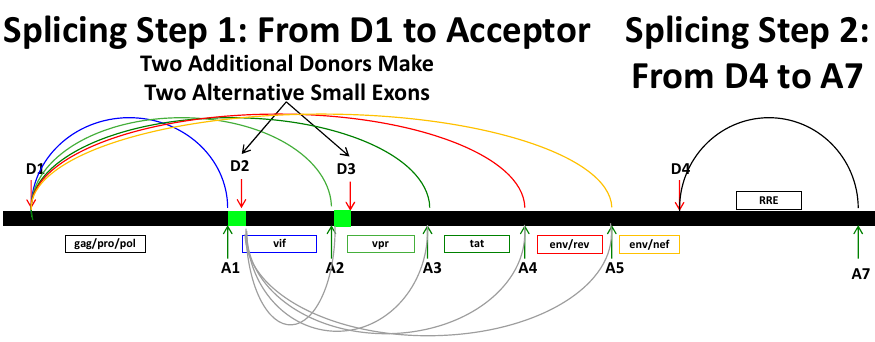
Figure 1. Splicing in HIV-1. Most HIV-1 transcripts remain unspliced. When splicing occurs, it always splices from D1 to one of the downstream acceptors, removing a section under a colored arc. Once having spliced from D1, the RNA may splice again to remove the sequence between D4 and A7 containing the vpu / env genes and the RRE (Rev Response Element; the region removed is sometimes called the env intron). Transcripts that undergo this additional D4 to A7 splice (needed to create tat , rev , and nef mRNAs, and short mRNAs for vif and vpr ) comprise the group of fully spliced transcripts. Transcripts that splice only from D1 but not from D4 to A7 ( vif , vpr , vpu / env mRNAs, and a long transcript isoform of tat mRNA) make up the partially/incompletely spliced transcripts. Two small exons (shown in green) can be included or skipped in mRNAs other than vif . Possible splice patterns that include the first small exon are shown when D1 splices to A1 and then splicing occurs from D2 to a downstream acceptor (shown by the gray arcs below the line). The second small exon can be included by a similar mechanism when splicing from D1 to A2 (or D2 to A2) is followed by splicing from D3 (not shown).